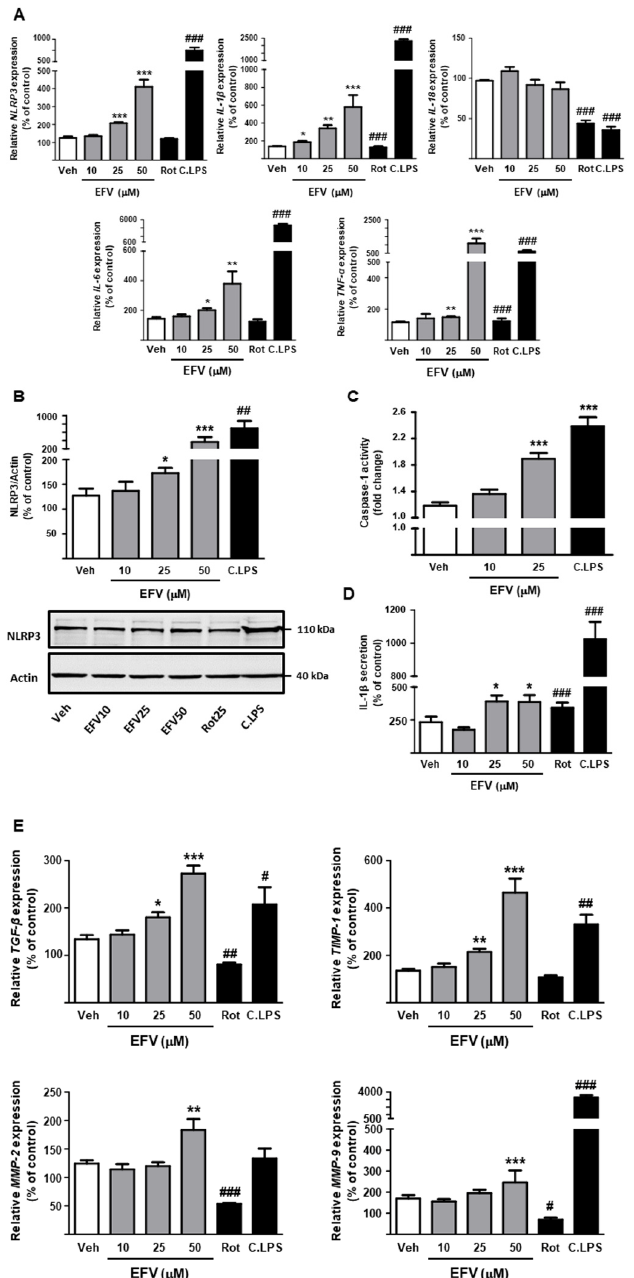
Figure 5. Efavirenz induces NLRP3 inflammasome-dependent pathways and upregulates fibrogen- esis in LX2 cells. ( A ) Analysis of relative mRNA expression levels of inflammasome-related genes and pro-inflammatory cytokines by RT-PCR. Data were normalized versus the housekeeping gene β -actin (n = 5–6). ( B ) Representative Western Blot image of NLRP3 and summary of densitometry data obtained from independent experiments after 24 h treatment (n = 6). ( C ) Determination of Caspase-1 activity in total extracts of hepatic stellate cells (n = 7). ( D ) ELISA assay of IL-1 β released from EFV-treated cells (n = 5). ( E ) Analysis of relative mRNA expression levels of different fibrogenic genes by RT-PCR. Data were normalized versus the housekeeping gene β -actin (n = 5–6). Data were represented as mean ± SEM, calculated as a percentage of control (untreated cells) and analyzed by a one-way ANOVA multiple comparison test followed by a Newman–Keuls test (* p < 0.05, ** p < 0.01, *** p < 0.001 versus the respective vehicle). Positive controls (rotenone -Rot- and cocktail of LPS -C.LPS-) were independently analyzed by a Student’s t -test ( # p < 0.05, ## p < 0.01, ### p <